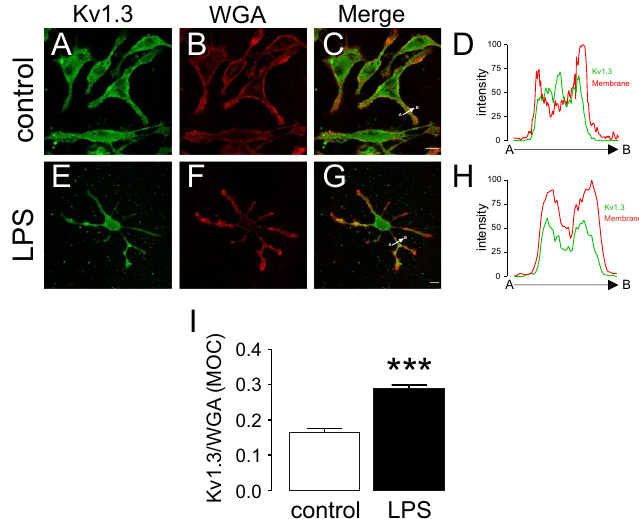
Figure 7. LPS-dependent activation of CY15 dendritic cells increases the abundance of Kv1.3 at the cell surface. CY15 cells were incubated in the presence (LPS) or the absence (control) of LPS for 24 h. Cells were first stained with WGA (membrane marker) and then immunolabeled against Kv1.3. ( A – D ) Control cells in the absence of LPS. ( E – H ) Cells treated with LPS. Green, Kv1.3; red, WGA; merged panels show colocalization between green and red. ( D , H ) Histogram of the pixel by pixel analysis of the section indicated by the arrow in ( C , G ), respectively. Bars represent 10 μm. ( I ) Mander’s overlap coefficient (MOC) quantifying the degree of colocalization between Kv1.3 and membrane surface (WGA) staining. White bar, control; black bar, LPS. Values are mean ± SE of n > 30 cells. ***p < 0.01 vs control (Student’s